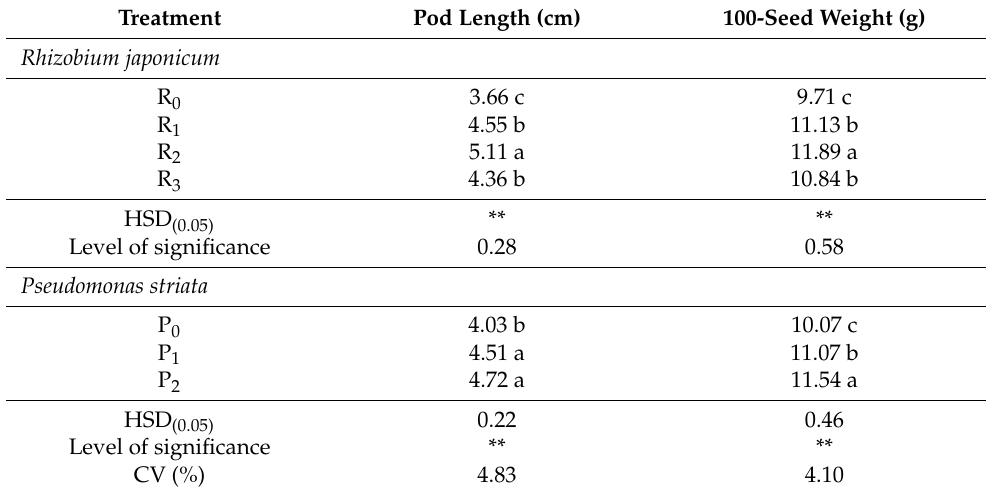
Table 4. Effect of Rhizobium japonicum and Pseudomonas striata on pod length and 100-seed weight of soybean.